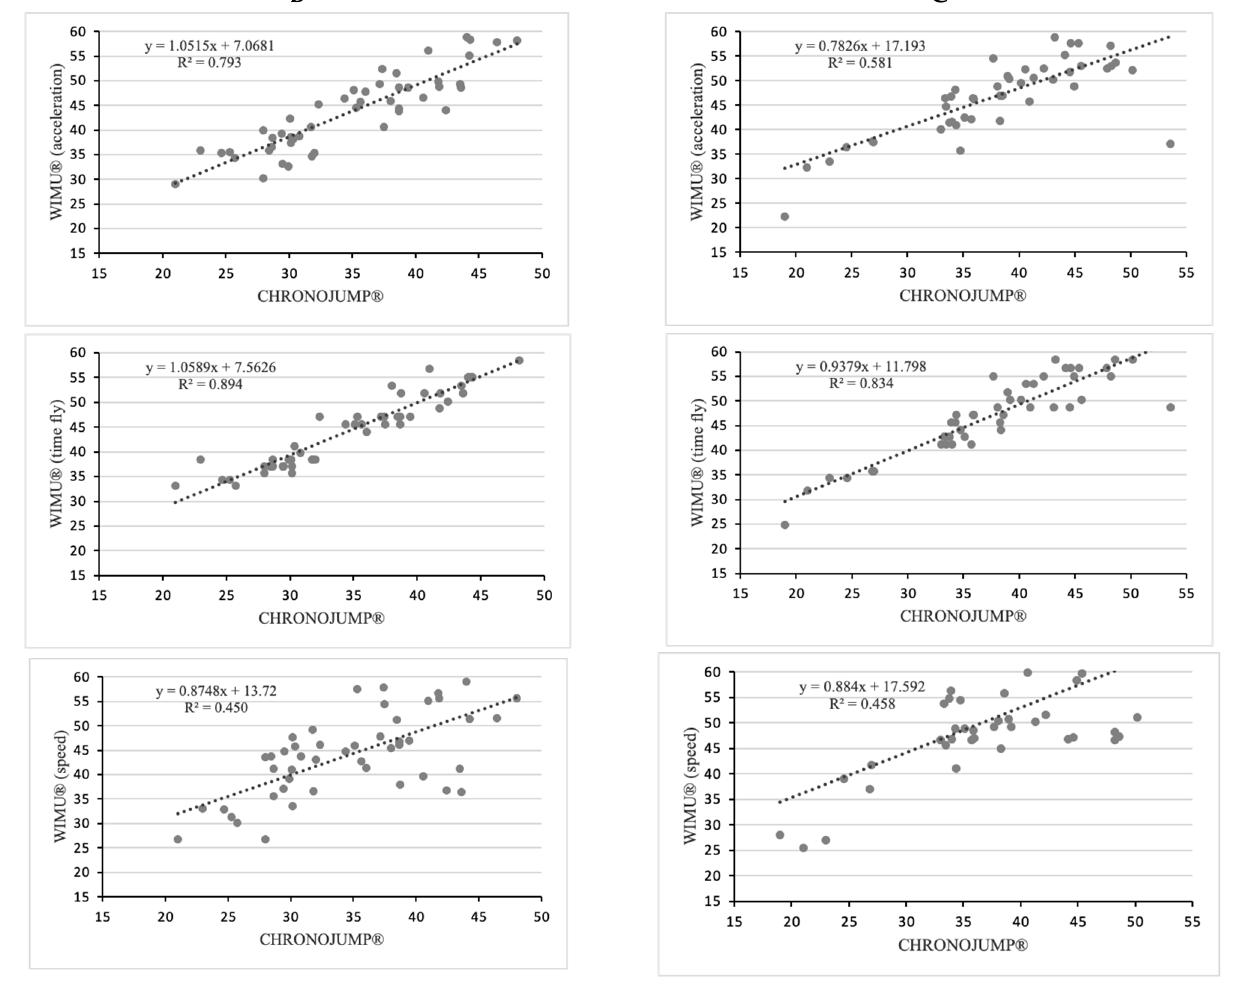
Figure 3. Relationship between CHRONOJUMP ® and WIMU ® in terms of acceleration, time fly or speed for ( A ) SJ: squat jump; ( B ) CMJ: countermovement jump; and ( C ) Abalakov jump. R 2 : Pearson’s multivariate coefficient of determination. The variables analyzed were the jump height measured in centimeters.